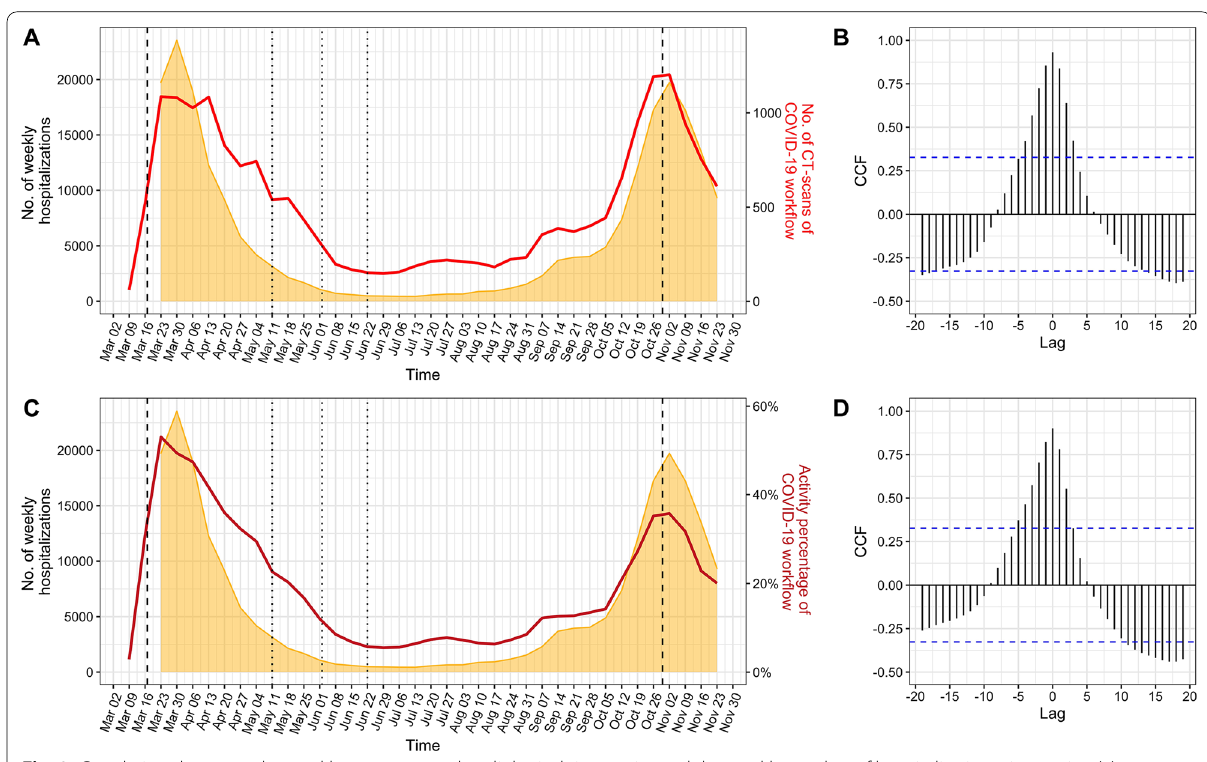
Fig. 3 Correlations between the weekly emergency teleradiological time‑series and the weekly number of hospitalisations time series. ( a ) Superimposition of the number of hospitalisations with the number of CT‑scans performed in the COVID‑19 workflow and ( b ) corresponding cross‑correlation plot. ( c ) Superimposition of the number of hospitalisations with the percentage of COVID‑19‑related activity, and ( d ) corresponding cross‑correlation plot. A spike above or below the blue lines on the cross‑correlation plots indicates a significant correlation of the two time series for the given lag